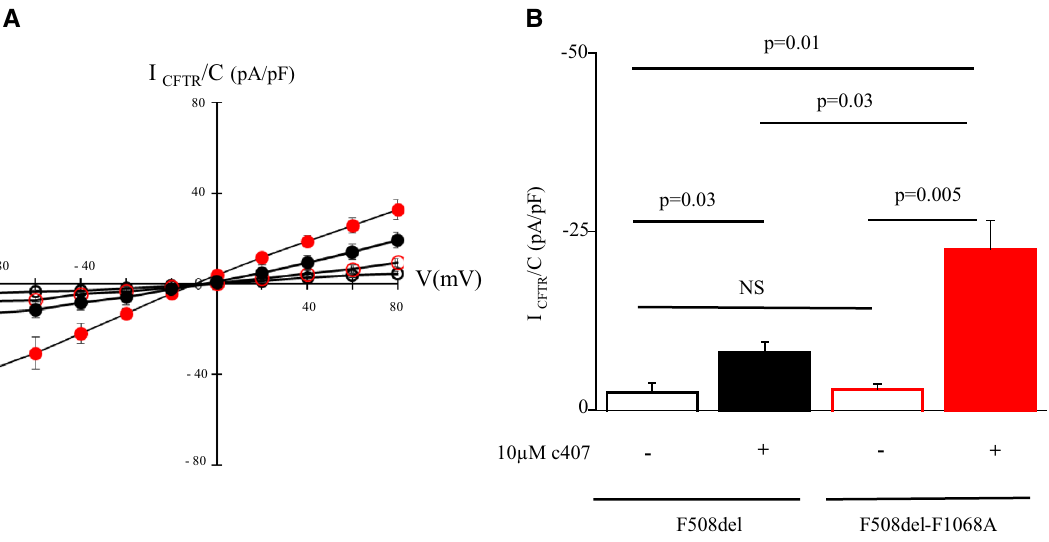
Figure 3. c407 restores F1068A-F508del-CFTR activity in HEK cells. ( A ) Whole cell patch-clamp experiments. Mean (SEM) CFTR-related current/voltage relationships obtained in HEK-293 cells transiently expressing F508del- or F508del-F1068A-CFTR. Current densities normalized to cell capacitance. (I CFTR /C) were calculated as the differences between current values in the presence of CPT-cAMP 400 µM/IBMX 100 µM minus current values after inhibition with CFTRinh-172 5 µM. Results are shown for F508del-CFTR expressing HEK cells incubated with NaCl 0.9% (black empty; n = 4) or 10 µM c407 (black; n = 7); F508del-F1068A-CFTR expressing HEK cells incubated with NaCl 0.9% (red empty; n = 4) or 10 µM c407 (red; n = 10 ). ( B ) Summary of the mean CFTR current amplitudes recorded at − 60 mV and normalized to cell capacitance of experiments in A. Wilcoxon statistics are